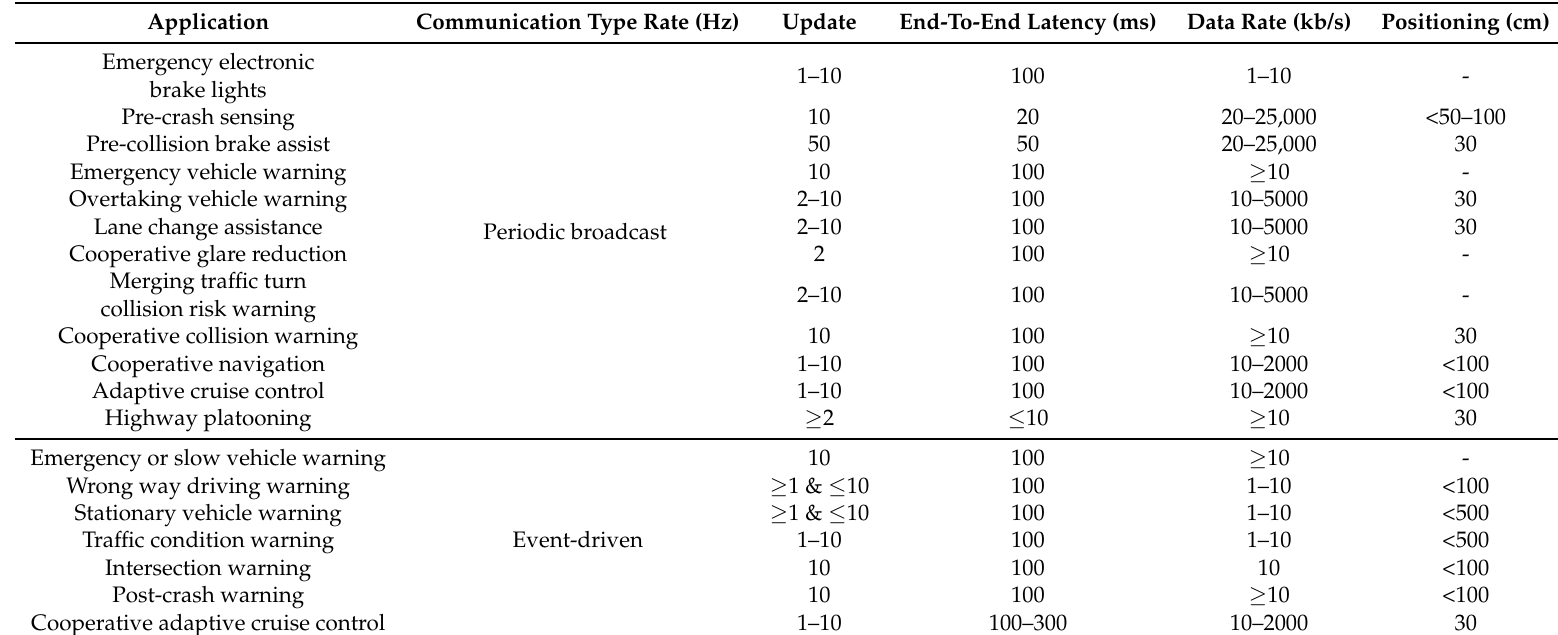
Table 1. Example requirements for typical V2V-related